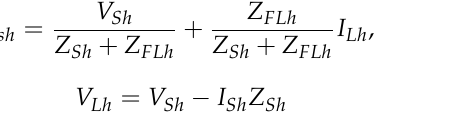
where Z FLh represents the parallel equivalent impedance of the filter’s impedance Z Fh